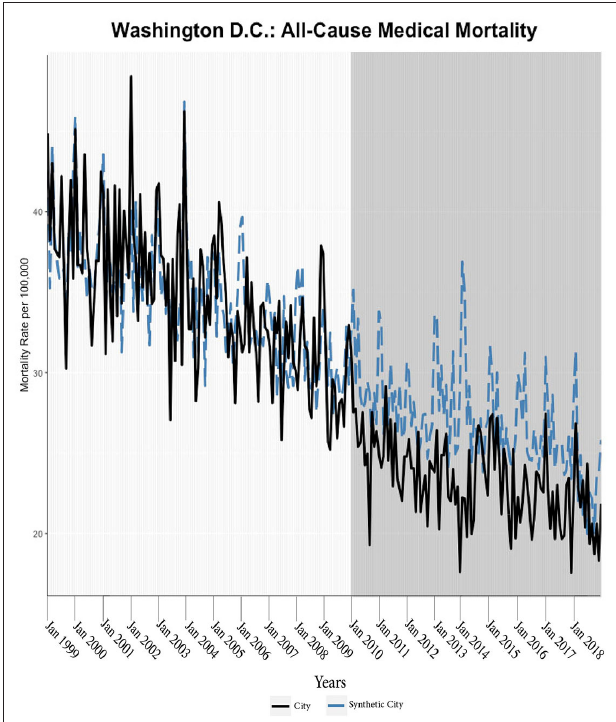
FIGURE 1 | All-cause mortality trends: Washington D.C. and synthetic control city. The blue dotted lines represent the generalized synthetic control prediction (synthetic city) of mortality rates while the solid black line is the observed mortality rate of the Medicaid expansion city. The vertical axis of the graphs represents the per 100,000-person mortality rates. The horizontal axis of the graphs represents time units (i.e., the first month of the year). The darker gray graph areas correlate with the start and duration of Medicaid expansion in the respective city (applicable for all the figures). FIGURE 2 | All-cause mortality trends: Baltimore and synthetic control